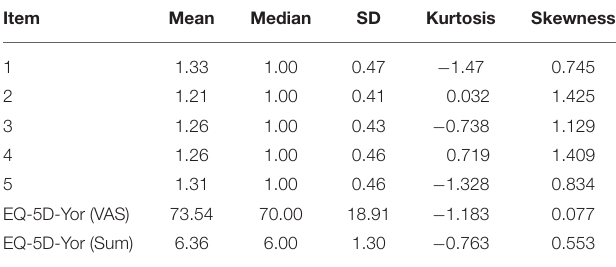
TABLE 2 | Descriptive summary of each of the items of the EQ-5D-Yor (Mean score, standard deviation, Skewness, and kurtosis).